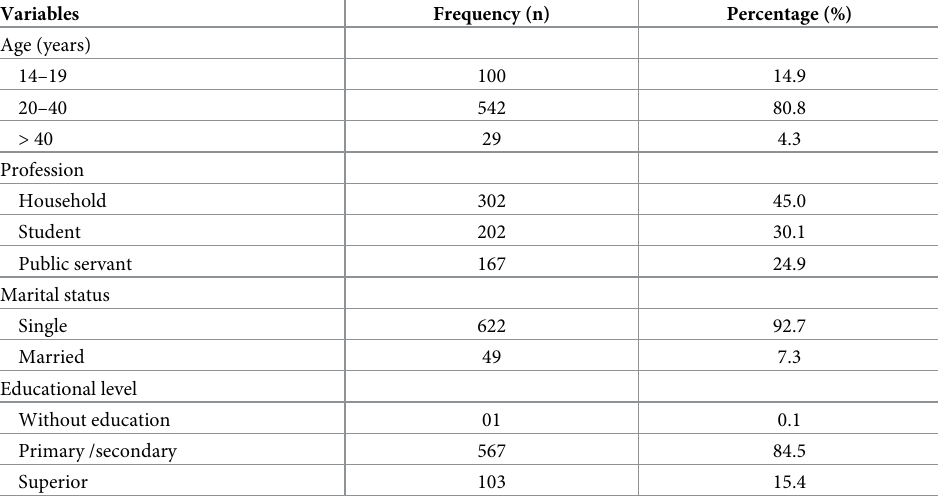
Table 1. Sociodemographic characteristics of